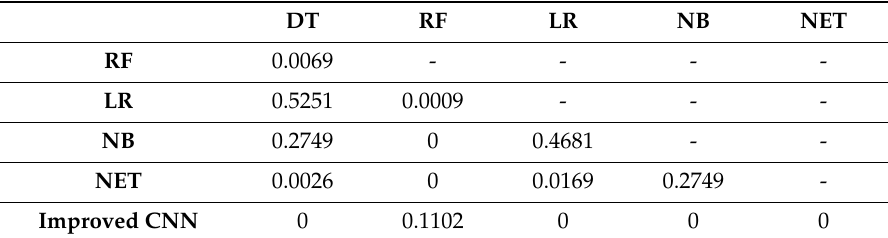
Table 11. Holm–Bonferroni test of prediction on the PSC dataset for